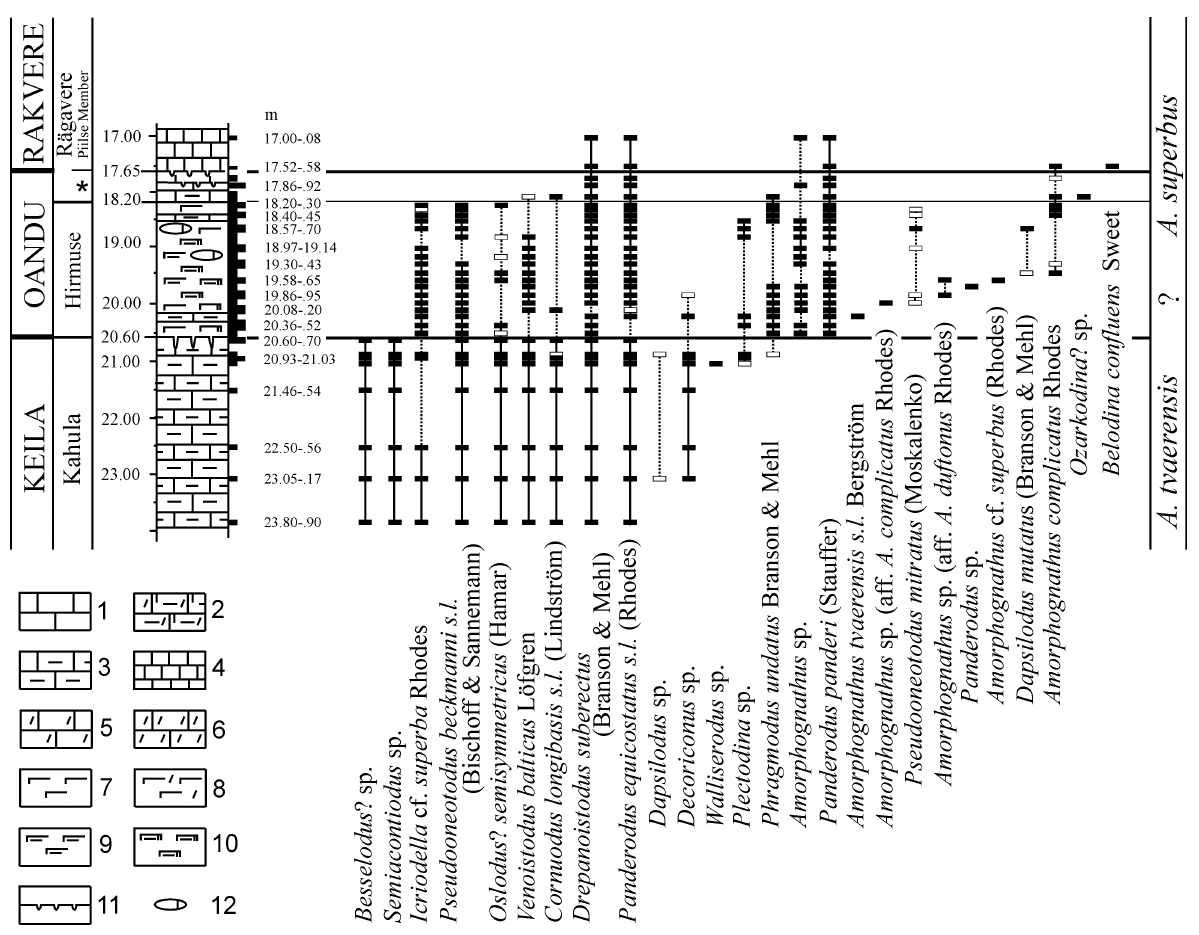
Fig. 3. Distribution of conodonts in the Virunurme (7721) core section. From left to right: stage; formation (* in the lower part of the Rägavere Formation indicates the interval of the Tõrremägi Member); depth; lithological log; samples and their intervals (in the uppermost Keila and Oandu stages only every second one is indicated); distribution of conodonts (black boxes – reliable identifications, white boxes – problematic identifications); conodont zones. Legend for Figs 3 and 6–8: 1, limestone (wackestone